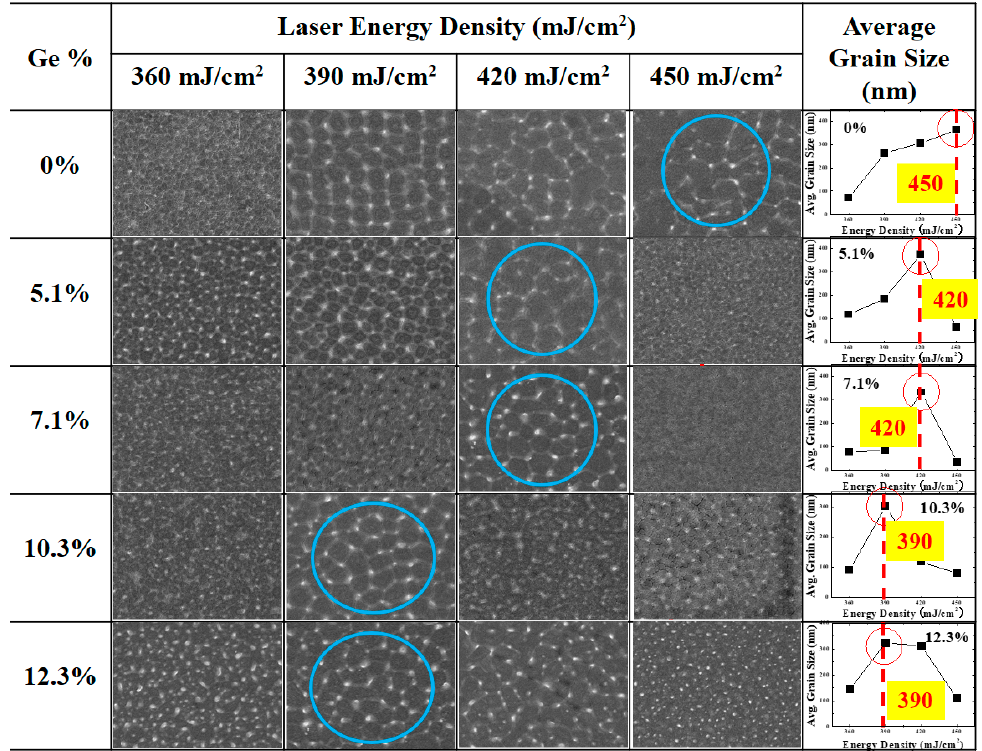
Figure 2. Grain images of poly-Si 1 − x Ge x films as a function of the laser energy density at different Ge concentrations. The largest grain sizes are shown in circles.